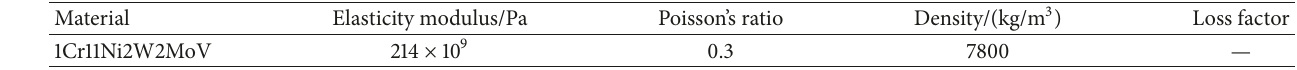
Table 3: Material parameters of the blade.